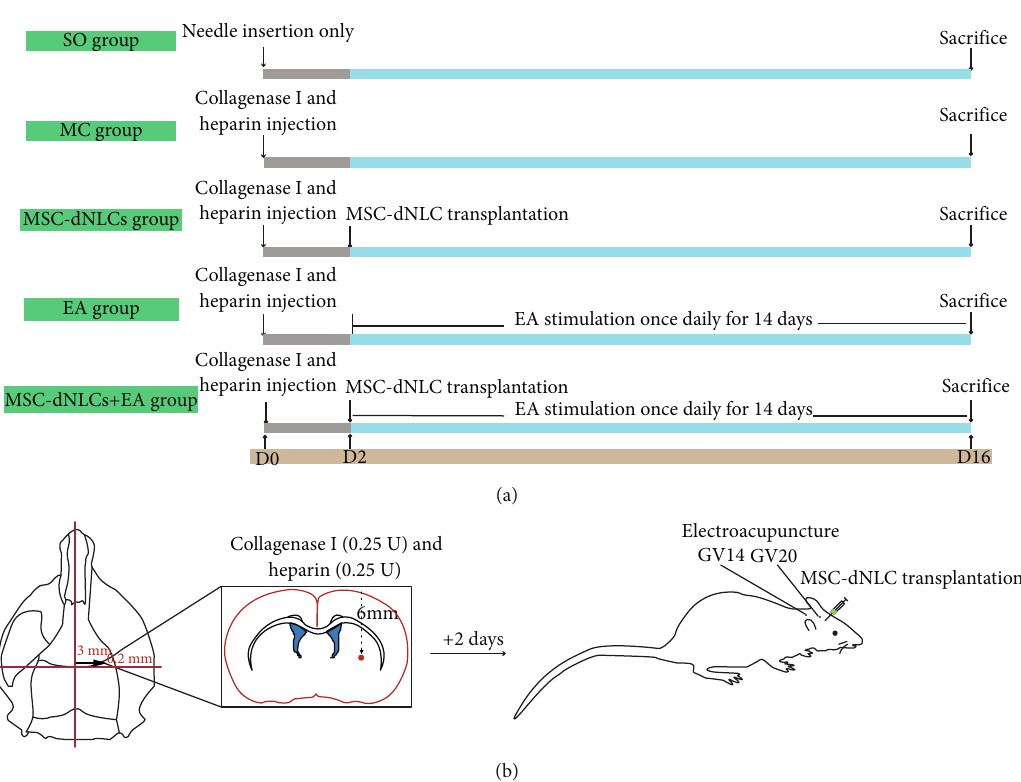
Figure 1: Conceptual illustrations of the experimental protocols. (a) Grouping and treatment strategies for experimental animals and brief timelines of the experimental procedures. (b) Schematic diagrams of the rat ICH model along with MSC-dNLC transplantation and EA